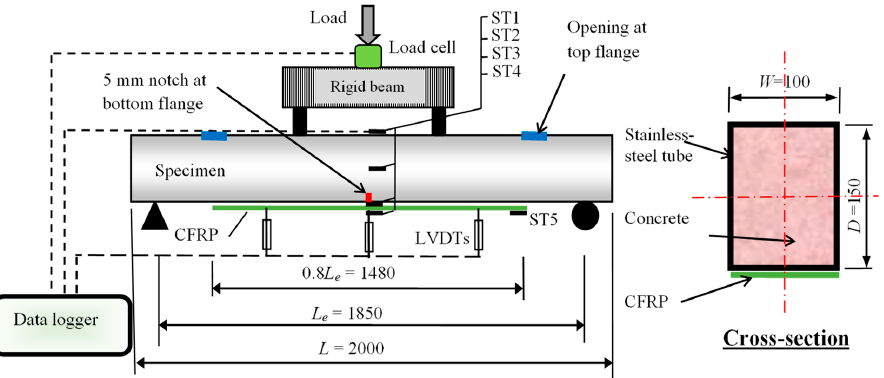
Figure 3. Typical RCFSST specimen test setup (unites in